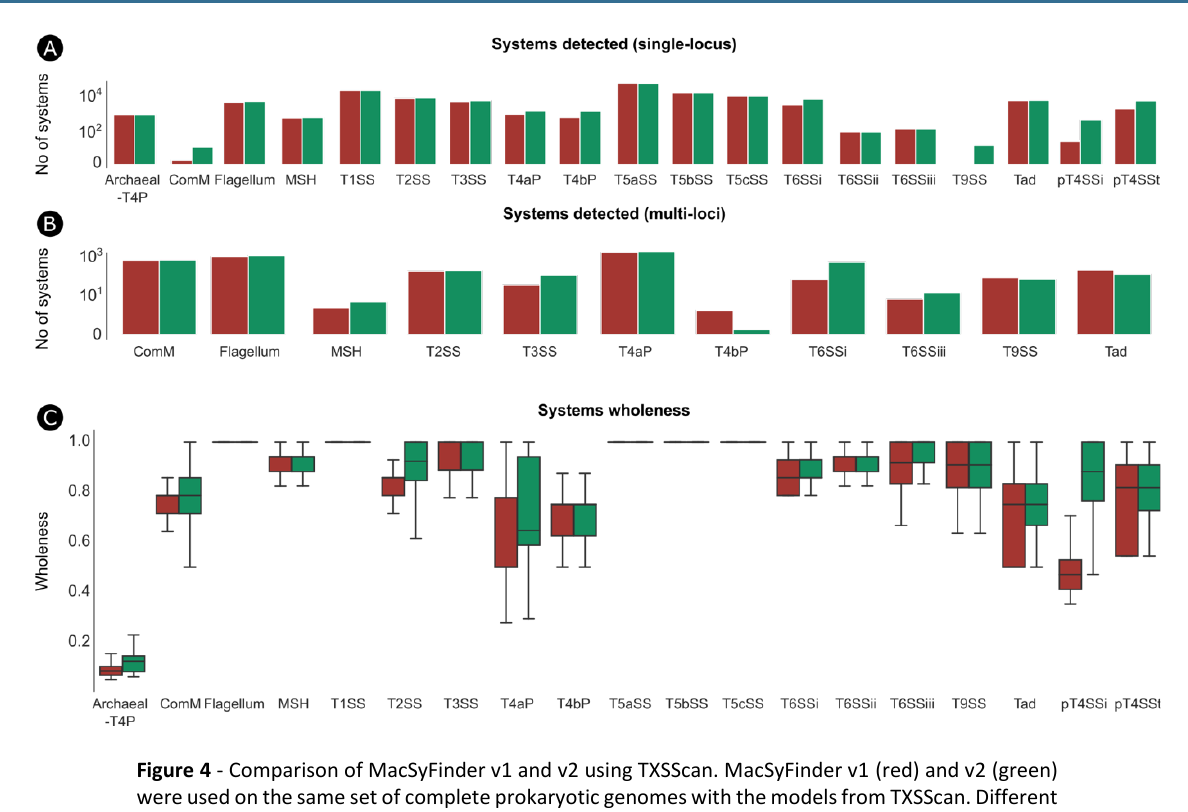
Figure 4 - Comparison of MacSyFinder v1 and v2 using TXSScan. MacSyFinder v1 (red) and v2 (green) were used on the same set of complete prokaryotic genomes with the models from TXSScan. Different statistics were used to compare their performance for systems’ detection: (A) the number of systems detected as “single-locus” and (B) “multi-loci”, and (C) a boxplot showing the distribution of the wholeness of detected systems. The wholeness of a detected system is the number of detected genes divided by the number of genes listed as part of the system in the system’s model definition (forbidden and neutral genes